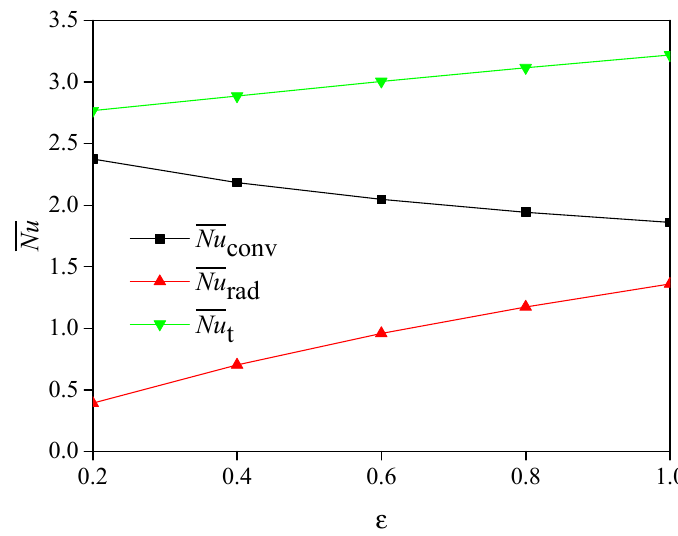
Figure 9. Variations of the average Nusselt number as a function of ε .